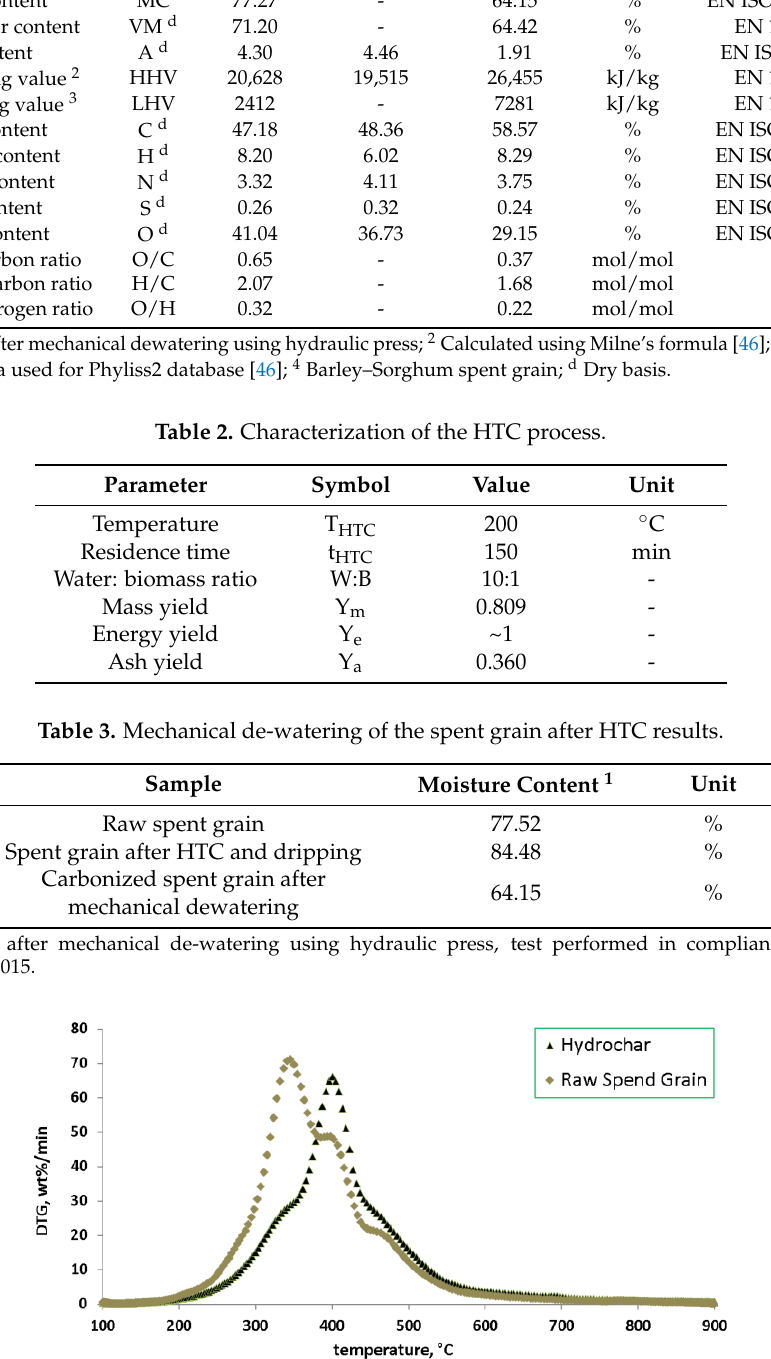
Figure 2. DTG diagram of raw spent grain and corresponding hydrochar.